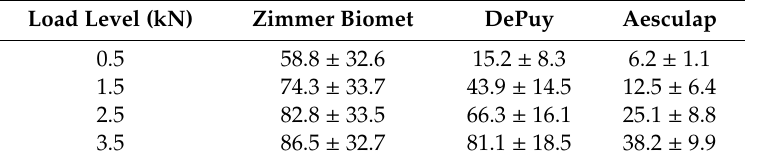
Table 1. Mean Relative Motion XYZ ± (µm).